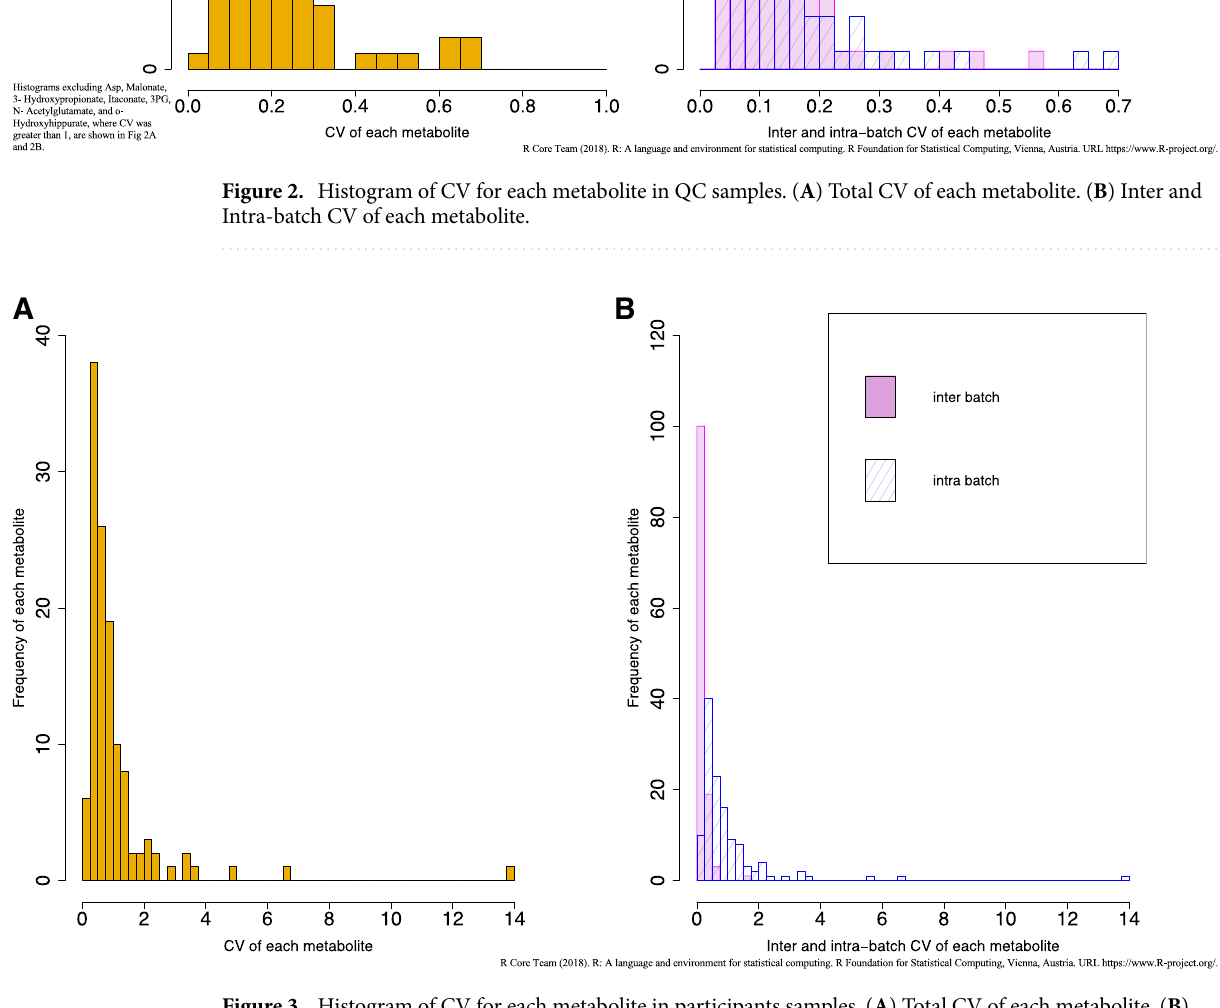
Figure 3. Histogram of CV for each metabolite in participants samples. ( A ) Total CV of each metabolite. ( B ) Inter and Intra-batch CV of each